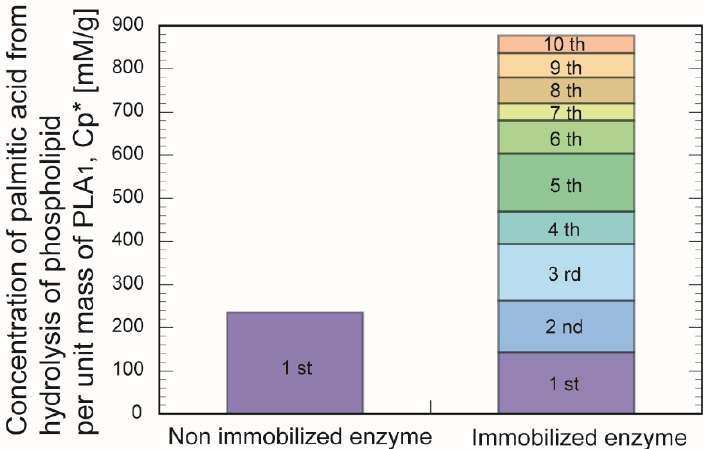
Figure 11. Accumulated yield of palmitic acid using immobilized phospholipase A 1 in W/O micro- emulsion system. It was compared with non-immobilized phospholipase A 1 (non-immobilized phospholipase A 1 ). Here, Hb was 0.075 mL, and C GA was 6%, respectively. The experiments were each conducted a minimum of three times. Cp*: concentration of palmitic acid from hydrolysis of phospholipid per unit mass of PLA 1 .